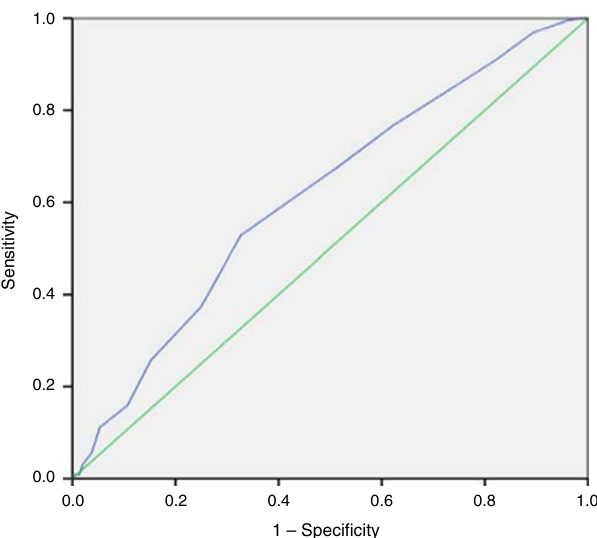
Table V. Cut-off point (CP), and sensitivity and specificity rates (%) with an estimated 95% confident interval (CI) for determined development of the screening instrument